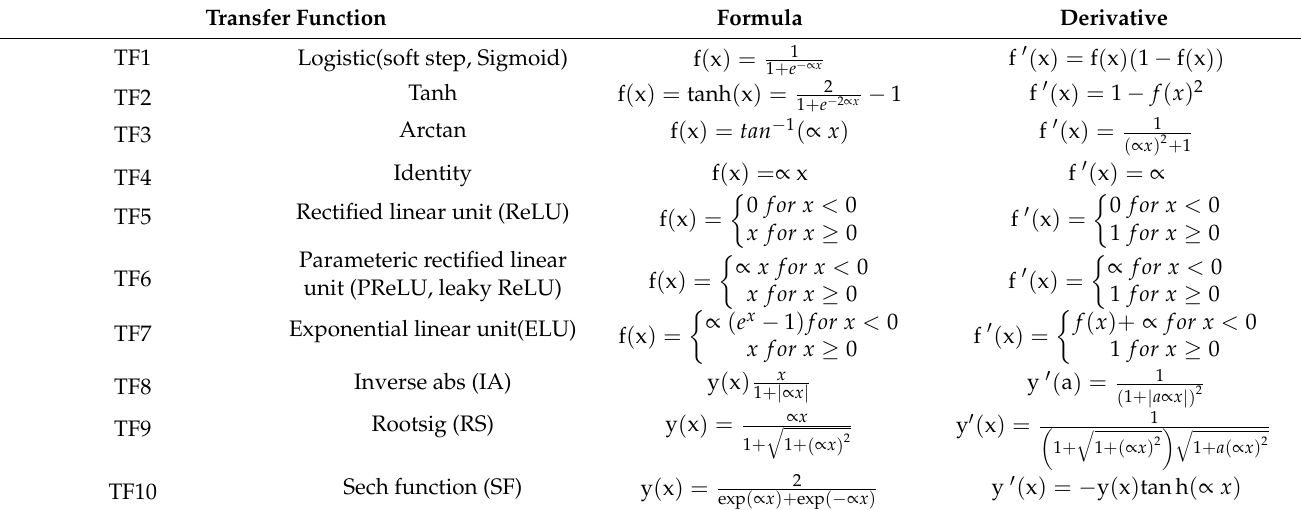
Table 2. Transform functions commonly used